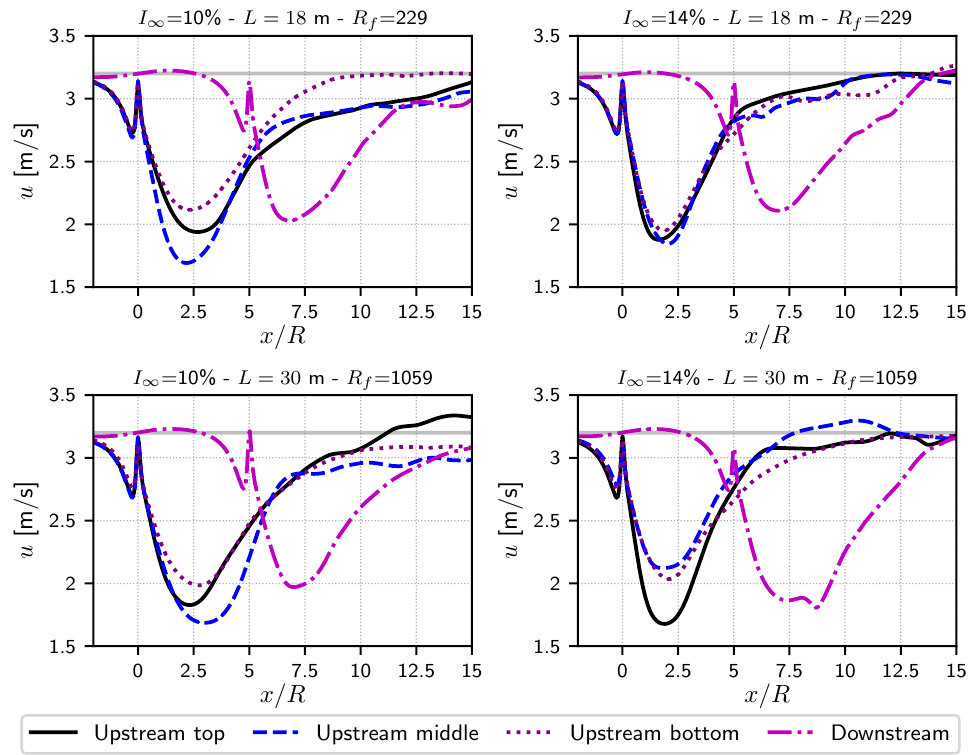
Figure 13. Time-averaged wake lines obtained for two turbulence intensities and two integral length scales (TSR = 4.1, σ ( λ ) = 75%). For each turbine, the corresponding line passes through its centre. The solid grey line depicts the incoming velocity U ∞ = 3.2